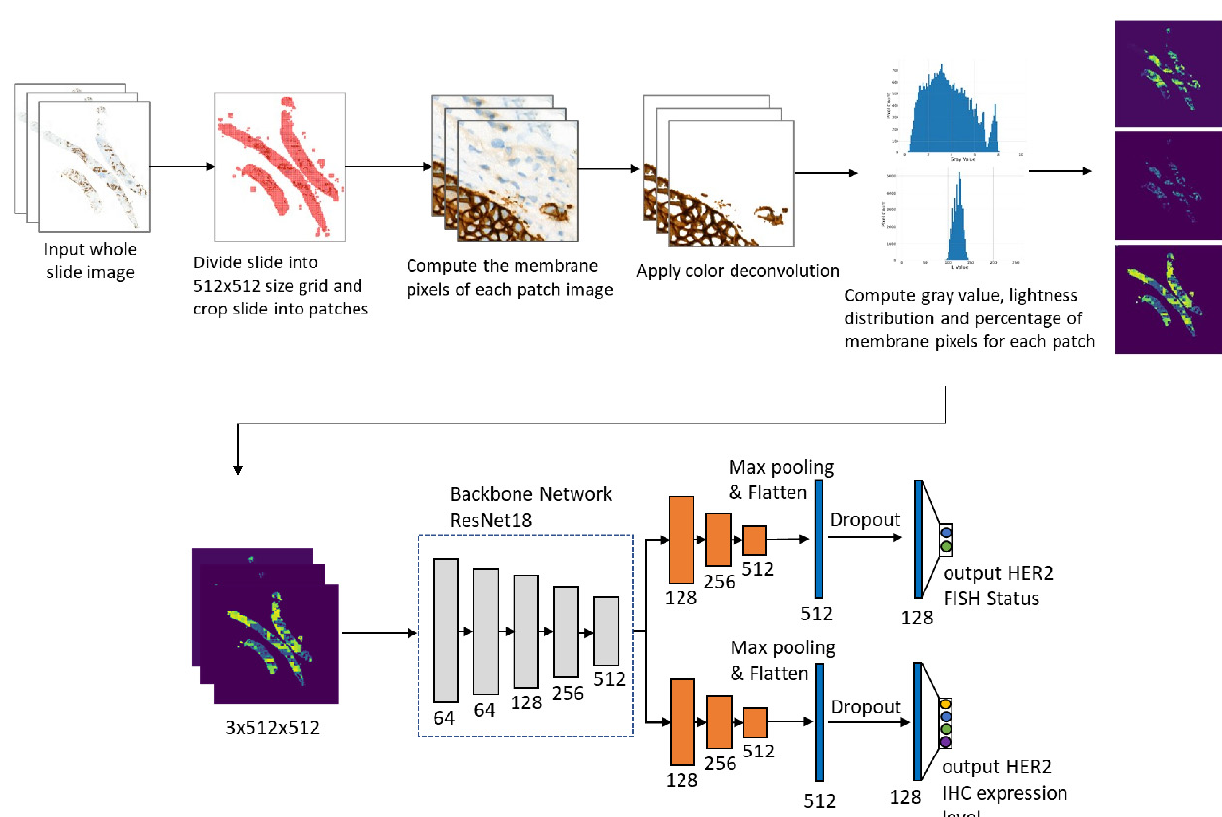
Figure 1. The workflow of our study includes the main steps for preprocessing slides and training the deep learning model. The numbers below the model block give the channel number